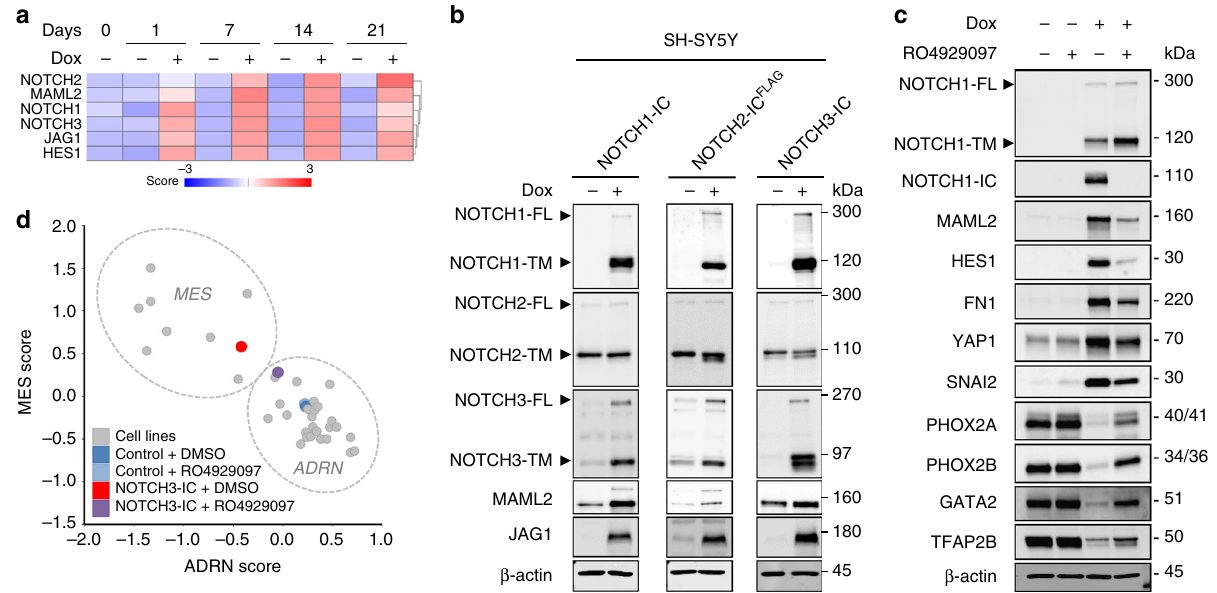
Fig. 5 NOTCH-IC paralogues induce a reciprocal feed-forward signaling cascade. a SH-SY5Y cells with inducible overexpression of NOTCH3-IC were pro fi led for gene expression up to 21 days. Z-scores of mRNA expression values are shown for JAG1 , NOTCH1 , NOTCH2 , NOTCH3 , MAML2 , and HES1 . The transcription of NOTCH receptors from endogenous loci is measured using probesets located in the 3 ′ UTRs of NOTCH1 (probeset 218902_at), NOTCH2 (probeset 202443_x_at) and NOTCH3 (probeset 203238_s_at). Notably, the 3 ′ UTR is absent in the NOTCH3-IC transgene. b . Western blot analysis of NOTCH1, NOTCH2, NOTCH3, MAML2, and JAGGED1 proteins in SH-SY5Y with NOTCH1-IC, NOTCH2-IC FLAG or NOTCH3-IC inducible overexpression. β -actin was used as loading control. Time of induction was 96 h. Source data are provided as a Source Data fi le. c Western blot analysis of SH-SY5Y cells with ( + dox) or without ( − dox) NOTCH3-IC expression that were cultured in the presence ( + ) or the absence ( − ) of the gamma-secretase inhibitor RO4929097. Protein lysates were analyzed for NOTCH pathway genes (NOTCH1, MAML2, HES1), MES markers (FN1, YAP1, SNAI2) and ADRN markers (PHOX2A, PHOX2B, GATA2, TFAP2B). β -actin was used as loading control. dox, doxycycline. Source data are provided as a Source Data fi le. d Analysis of MES and ADRN mRNA signature scores in SH-SY5Y cells with NOTCH3-IC induction that were treated with the gamma-secretase inhibitor RO4929097. Control cells (-dox) treated with DMSO or RO4929097 are shown in dark- and light blue, respectively. NOTCH3-IC expressing cells with DMSO or RO4929097 are shown in red and purple, respectively. Cells were induced with doxycycline and treated with RO4929097 for 14 days. Dashed circles indicate groups of MES- or ADRN-type cell lines as previously determined